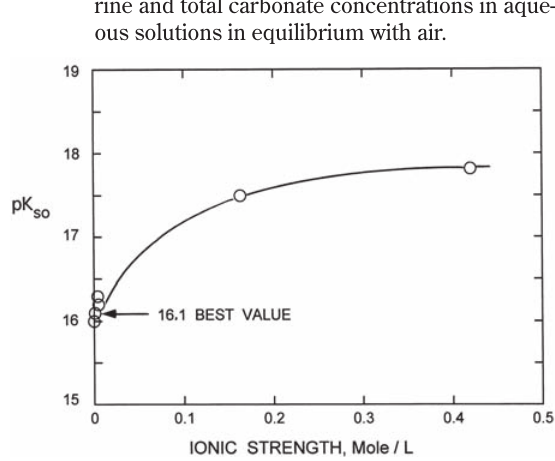
Fig. 4 The solubility product of synthetic cerium bastn- aesite in aqueous solutions as a function of ionic strength. Table 3 Chemical Reactions in the Synthetic Cerium Bastnaesite-Water System Open to the Atmo- sphere